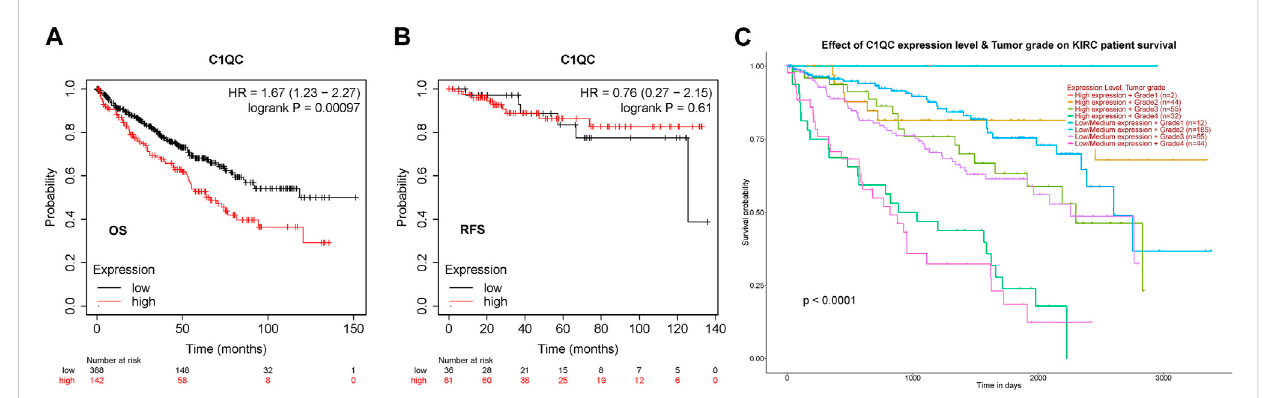
FIGURE 2 Clinical signi fi cance of C1QC in KIRC. (A, B) The association of C1QC expression with KIRC patients ’ OS and RFS. (C) The association of C1QC expression with KIRC tumor grades.